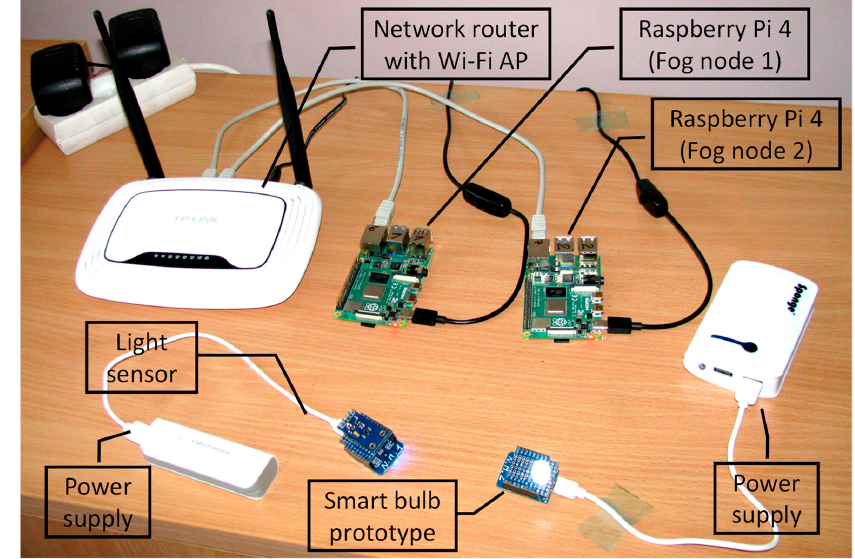
Figure 8. Flow chart of the service placement finding method.